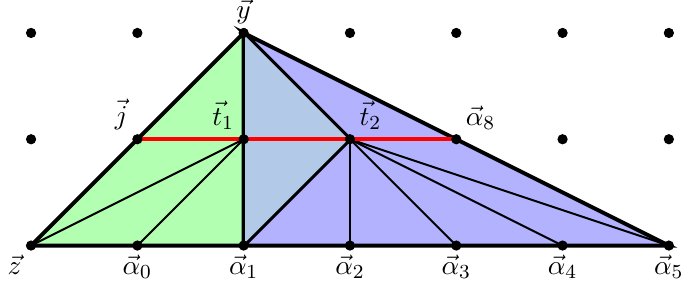
Figure 6 . A triangulation of the rank two facet \involving" all vectors. The red line indicates the ruling of the two surfaces, along which a blow-down produces an su (3) gauge